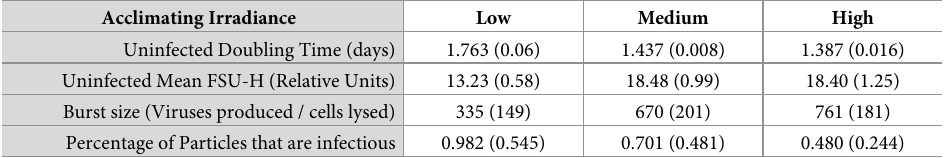
Table 1. Summary of acclimation conditions including host doubling time (S3 Fig), mean forward scatter (FSU-H) determined by flow cytometry, burst size (MCP copies produced/ A . anophagefferens cell lysed), and per- cent of particles determined to be infectious (from Fig 1). Standard deviation of each value is recorded within the